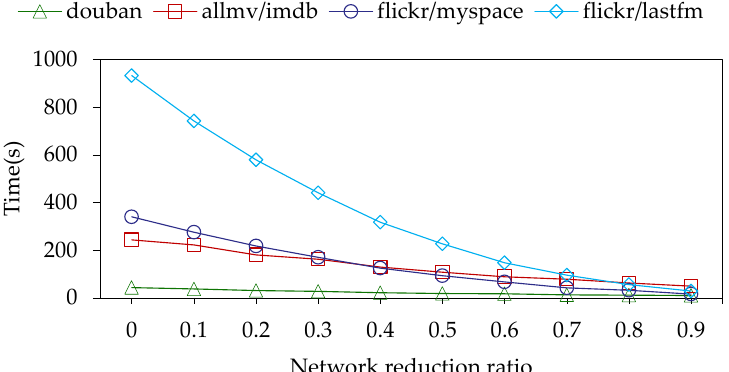
Figure 2. Effect of compression ratio on running time.